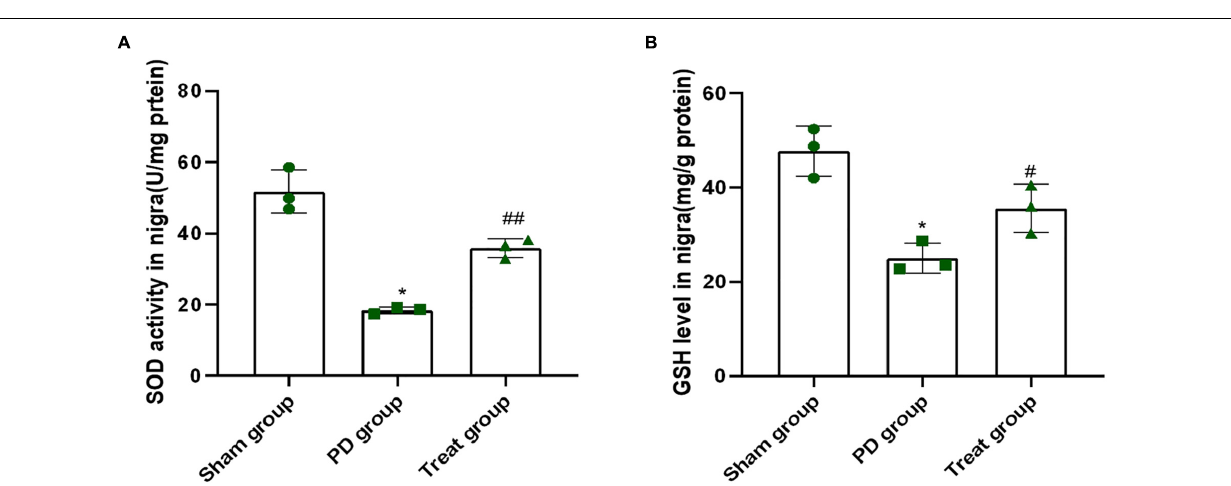
FIGURE 3 | ALA inhibits the decrease in the activity of SOD and GSH in the SN of the rat model of PD induced by 6-OHDA. (A) . The activity of SOD in the SN was dramatically suppressed by 6-OHDA and was rescued by ALA. (B) The level of GSH in the SN was significantly suppressed by 6-OHDA and was rescued by ALA. Data were expressed as the means ± SD analyzed by one-way ANOVA ( n = 3). Statistical significance: * P < 0.01 vs. sham group; # P < 0.05, ## P < 0.01 vs. PD